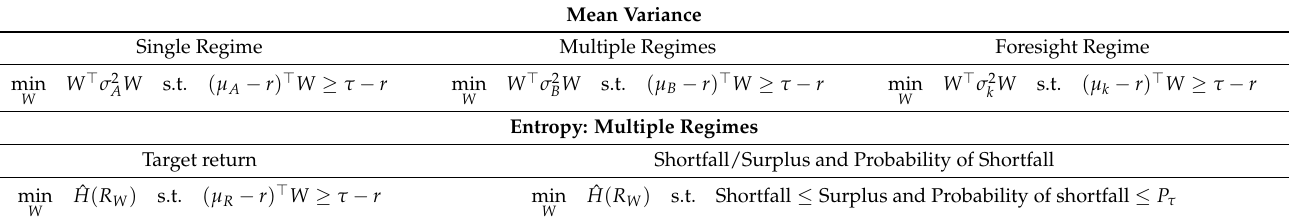
Table 6. Alternative Portfolio